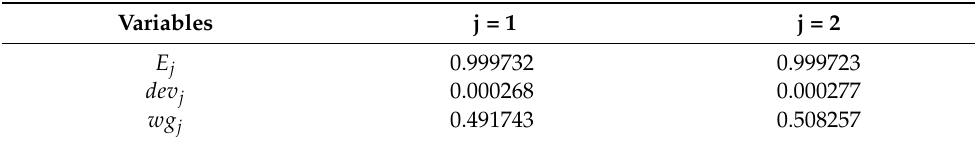
Table 7. Obtained results for the the assigned weight to each criterion.